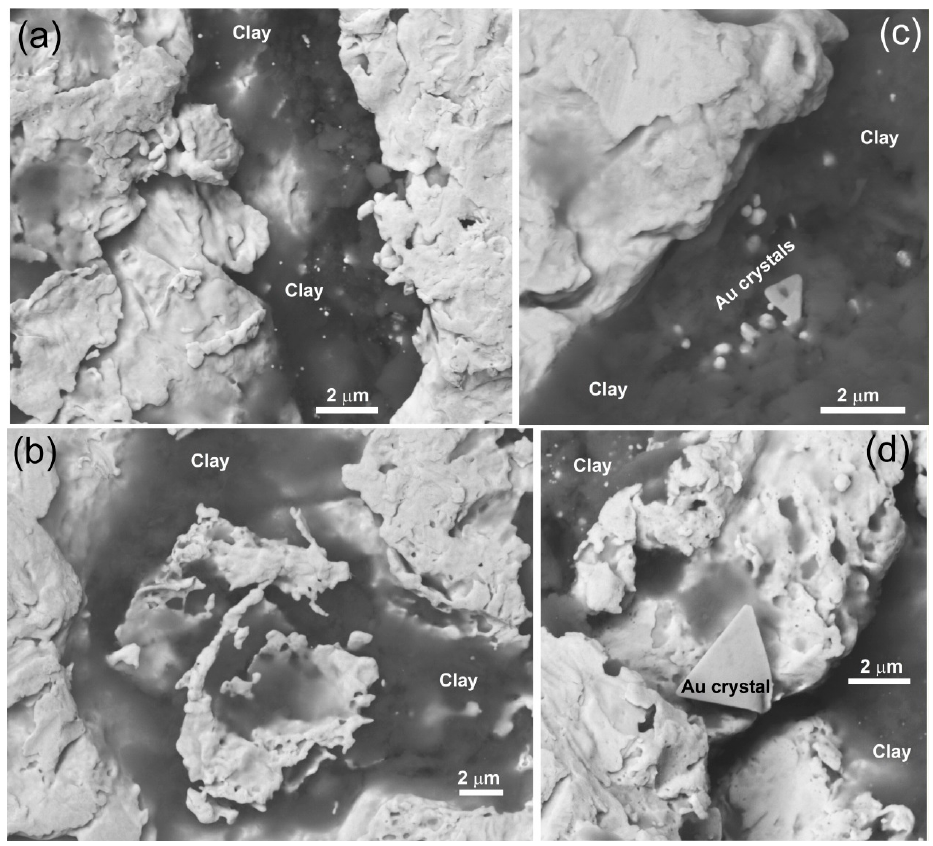
Figure 8. Backscatter electron images of micron and submicron scale overgrowth gold on Waikaia gold particles and exterior clay-filled cavities in those particles. The electron beam penetrates into the clay to image nanoparticulate gold intergrown with the clay. ( a ) Irregular gold overgrowths form thin plates on the surface of the detrital particle; ( b ) Lacy overgrowth gold is intergrown with clay in a cavity; ( c ) Nanoparticulate triangular and dodecahedral gold crystals are intergrown with clay in a cavity; ( d ) A large triangular gold crystal has overgrown a variably plated gold particle surface.